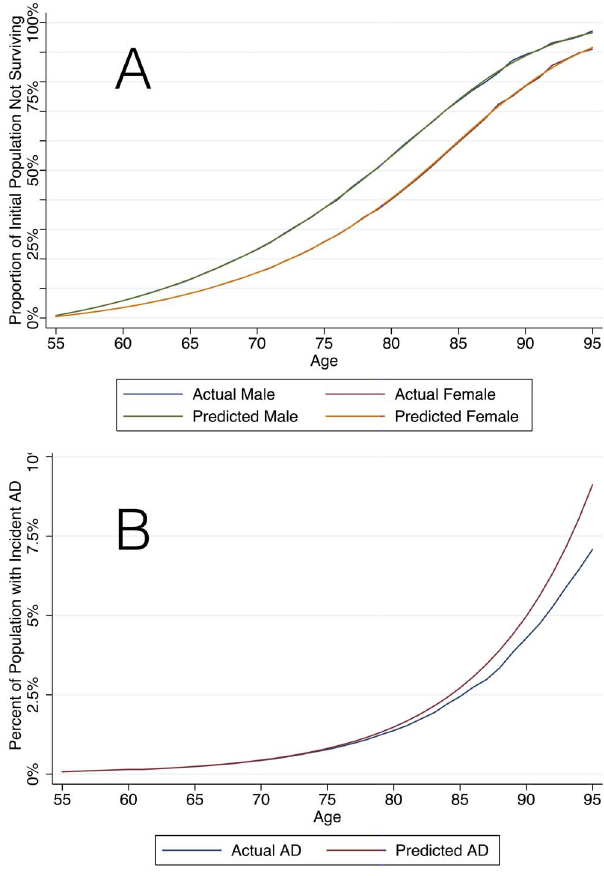
Figure 2. Study Population Validation . Panel A demonstrates the proportion of the initial population surviving at each age group in the simulated population (‘‘Actual’’) compared to CDC life table data (‘‘Predicted’’) and Panel B demonstrates the proportion of the simulated population with incident AD (‘‘Actual’’) compared to the Brookmeyer estimates